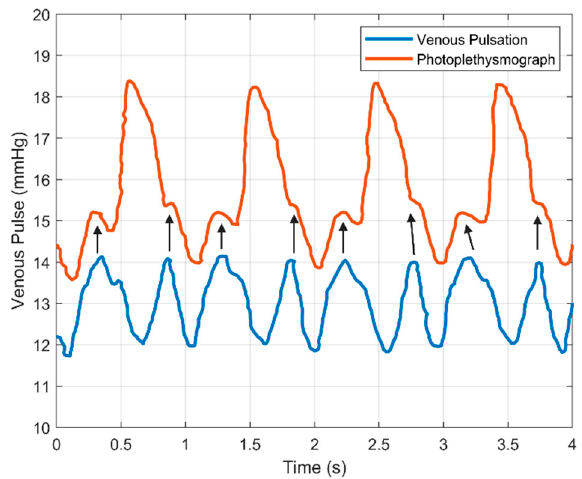
Figure 6. Venous pulse within a PPG. The blue waveform is the venous waveform, and the red waveform shows the PPG waveform. Adapted from Shelley et al. [116]. Created with